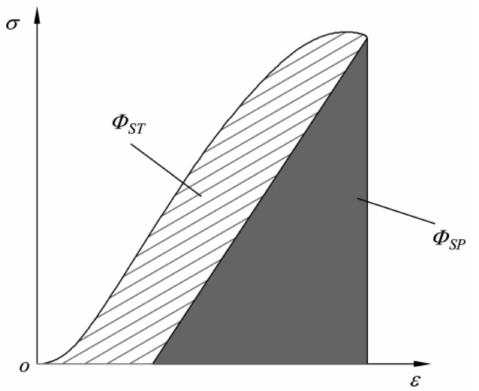
Figure 2. The test curve of W et